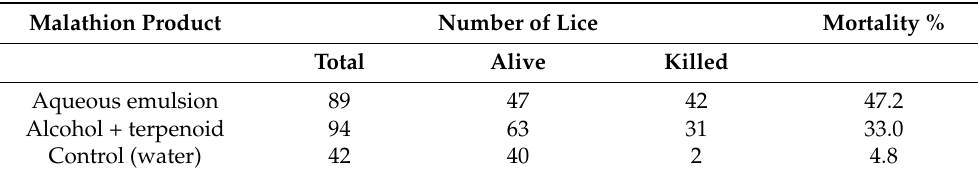
Table 1. Survival of resistant head lice treated using different 0.5% malathion preparations, one a simple aqueous emulsion and the other an alcoholic solution containing 12% terpenoids. Malathion Product Number of Lice Mortality % Total Alive Killed Aqueous emulsion 89 Alcohol +